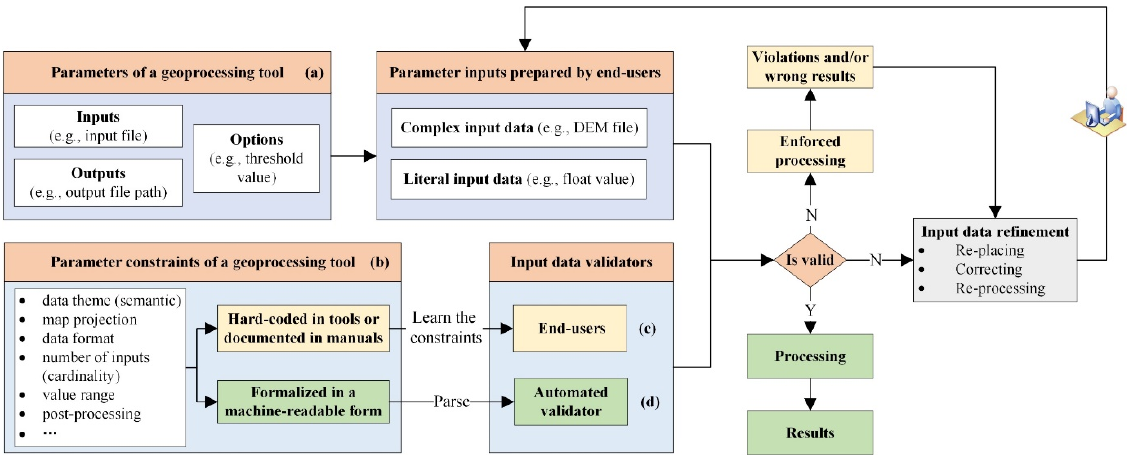
Figure 1. The roles of parameter constraints and input data validation in geoprocessing. ( a ) Different types of parameters of a geoprocessing tool; ( b ) examples of parameter constraints and how to use them for validations; ( c ) input data validation depends on users; ( d ) automated input data validation using specifically designed validators.